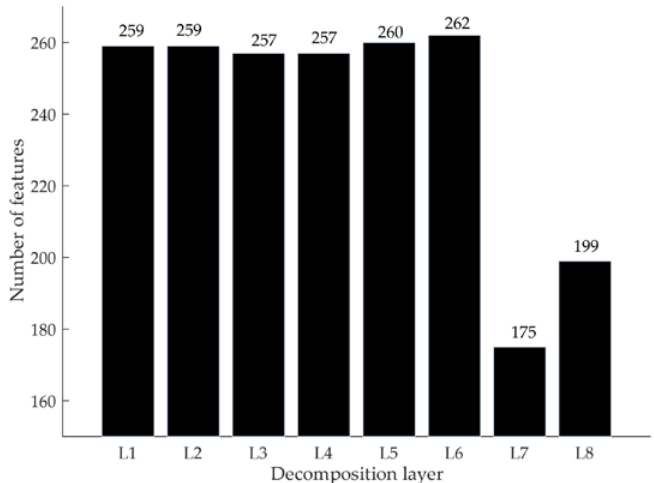
Figure 5. The number of wavelength points of L1 to L8 passing through the threshold, which was set to 0.8.